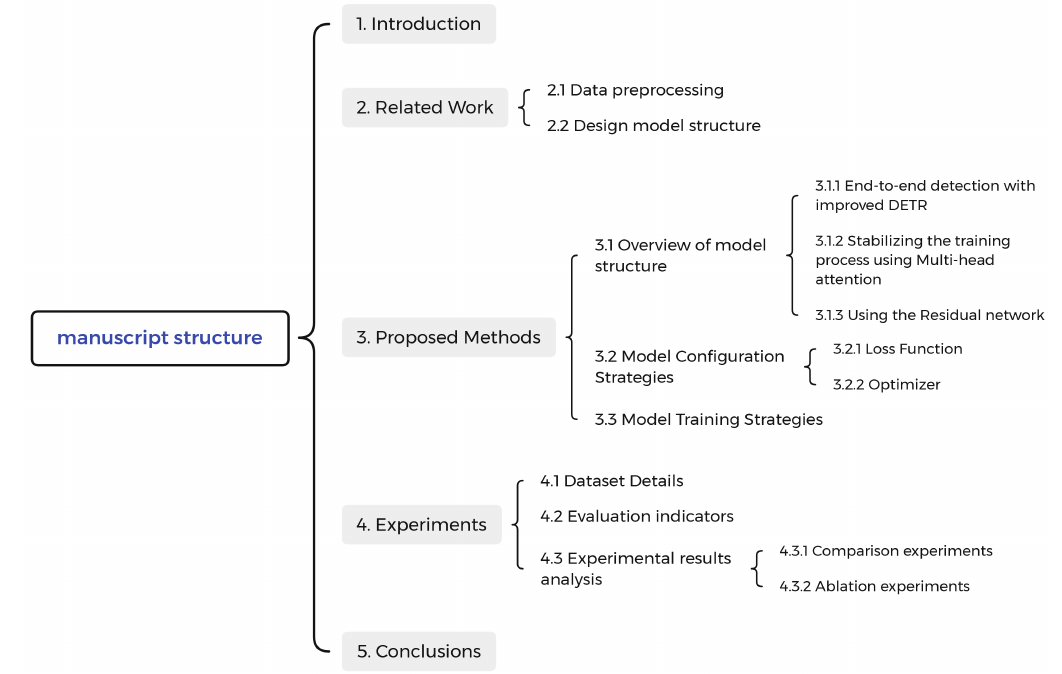
Figure 1. Manuscript